Question: Reading the figure, is the described quantity rising or falling?
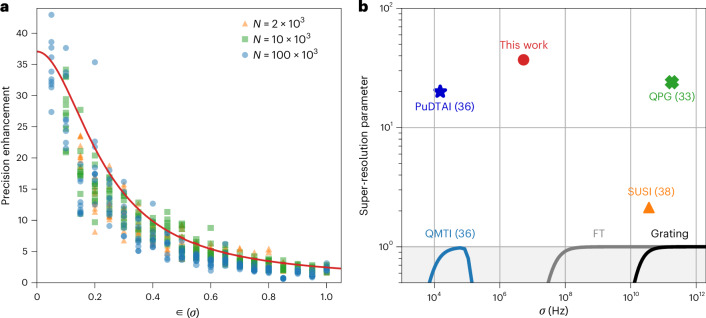
Answer: increasing